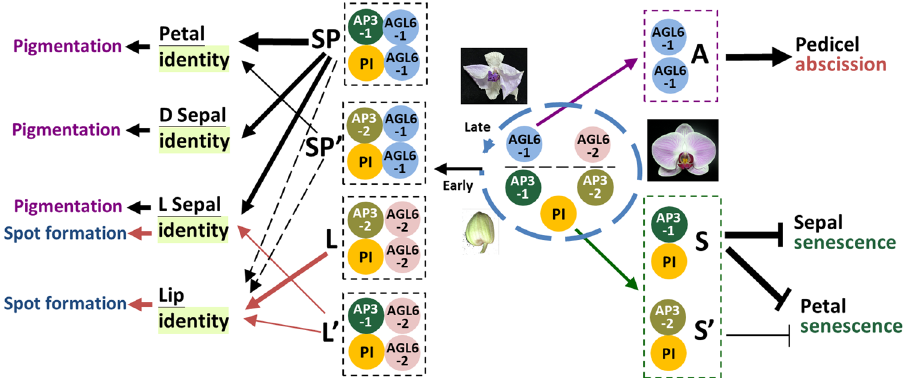
Fig. 5 The multifunctional evolution of P-code genes in orchids. In orchids, two AGL6 ( OAGL6-1 , -2 ), two AP3 ( OAP3-1 , -2 ) and one PI ( OPI ) gene play key roles (blue dashed circle) in regulating perianth identity and other developmental processes in fl owers. During early fl ower initiation, the L (OAP3-2/ OAGL6-2/OPI) complex determines the lips, whereas the SP (OAP3-1/OAGL6-1/OPI) complex determines sepal/petal identity. In addition, an L ’ complex (OAP3-1/OAGL6-2/OPI) is also likely involved in regulating the lips and lower parts of the lateral sepal identity/morphology, whereas an SP ’ complex (OAP3-2/OAGL6-1/OPI) is likely involved in regulating the petal and lip identity/morphology. After fl ower organ identity has been determined, SP/SP ’ complexes have an additional function in positively regulating (black arrow → ) anthocyanin accumulation and pigmentation in sepals/petals, whereas L ’ /L complexes can regulate (red arrow → ) red spot formation in lateral sepals and lips. During fl ower development, the OAP3-1/OPI B class proteins from the SP complex could form a separate senescence complex (S) to suppress ( ⊣ ) the senescence of the sepal/petal in orchids. An S ’ complex (OAP3-2/OPI/X) with minor complementary function for the S complex could suppress ( ⊣ ) petal senescence. The orchid OAGL6-1 from the SP complex may form an abscission complex (A) to ensure ( → ) the abscission of the pedicel from senescent fl owers during the late stage of fl ower development. AGL6-1: OAGL6-1, AGL6-2: OAGL6-2, AP3-1: OAP3-1, AP3-2: OAP3-2, PI: